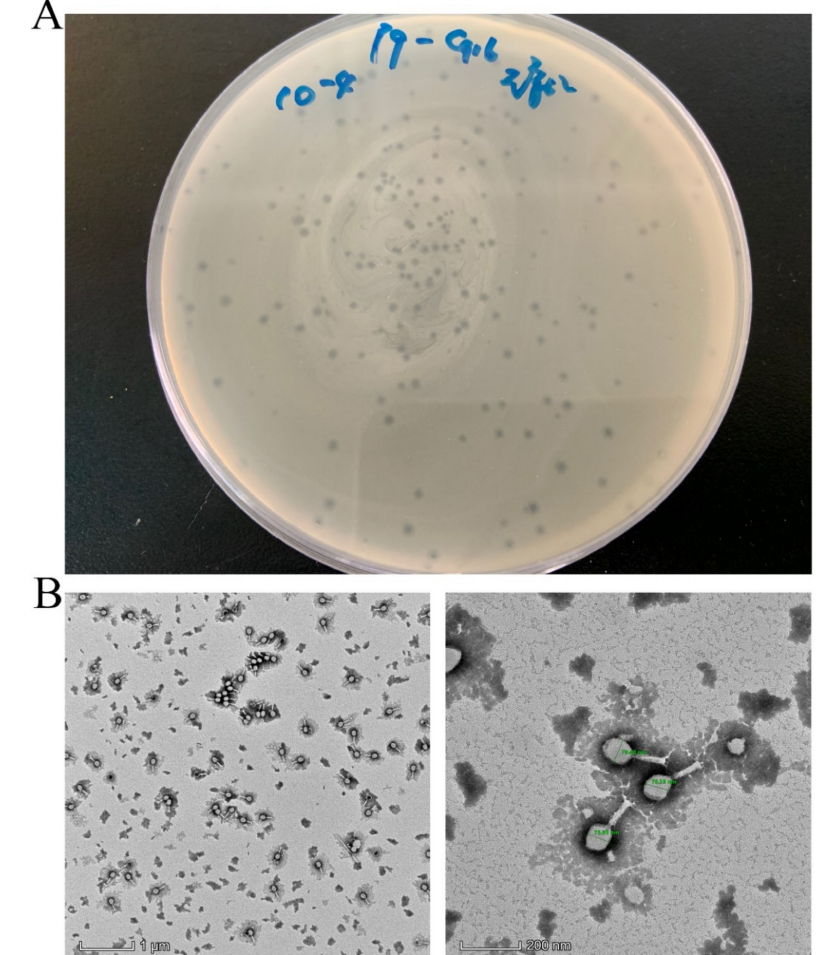
Figure 2. Morphological characteristics of phage AH67C600_Q9. ( A ) Culture map of phage AH67C600_Q9 plaques in double-layer agar. ( B ) TEM images of phage AH67C600_Q9. The longitu- dinal diameter of the capsid approximately equaled the tail